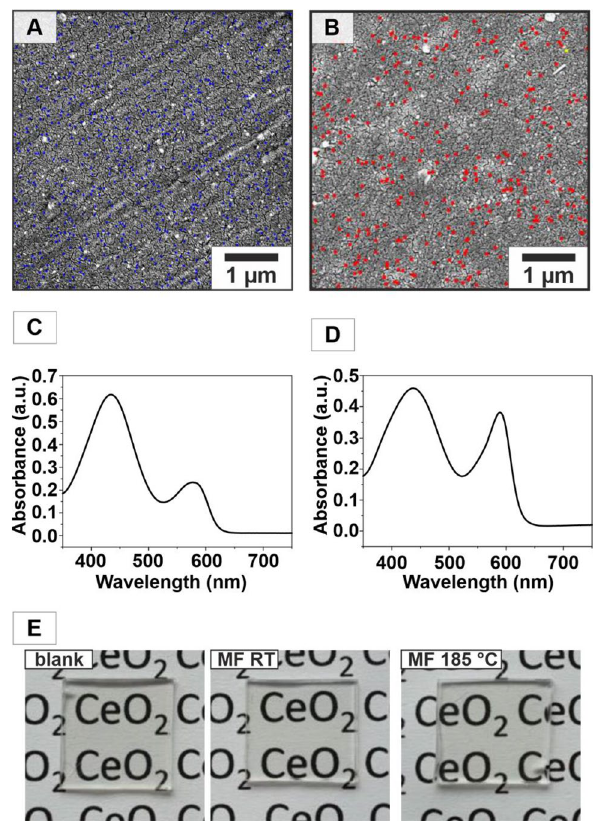
Figure 5. CeO 2 /polycarbonate panels. ( A ) SEM images of polycarbonate panels with CeO 2 NPs from segmented flow synthesis with corresponding (EDX mapping marked as blue dots for Ce). ( B ) Polycarbonate panels with CeO 2 NPs from segmented flow synthesis, annealed at 185 °C (EDX mapping marked as red dots). ( C , D ) Spectral changes induced by oxidative bromination of PR after 72 h of the CeO 2 /polycarbonate panels with ( C ) CeO 2 NPs (not annealed) and ( D ) CeO 2 NPs (annealed at 185 °C). ( E ) Image of a blank polycarbonate panel (left) polycarbonate panels with CeO 2 NPs (not annealed/185